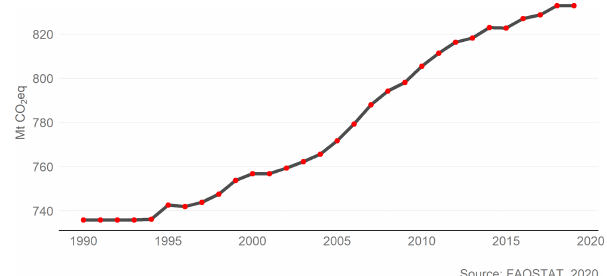
Figure 6. Global emissions from drained organic soils from 1990–